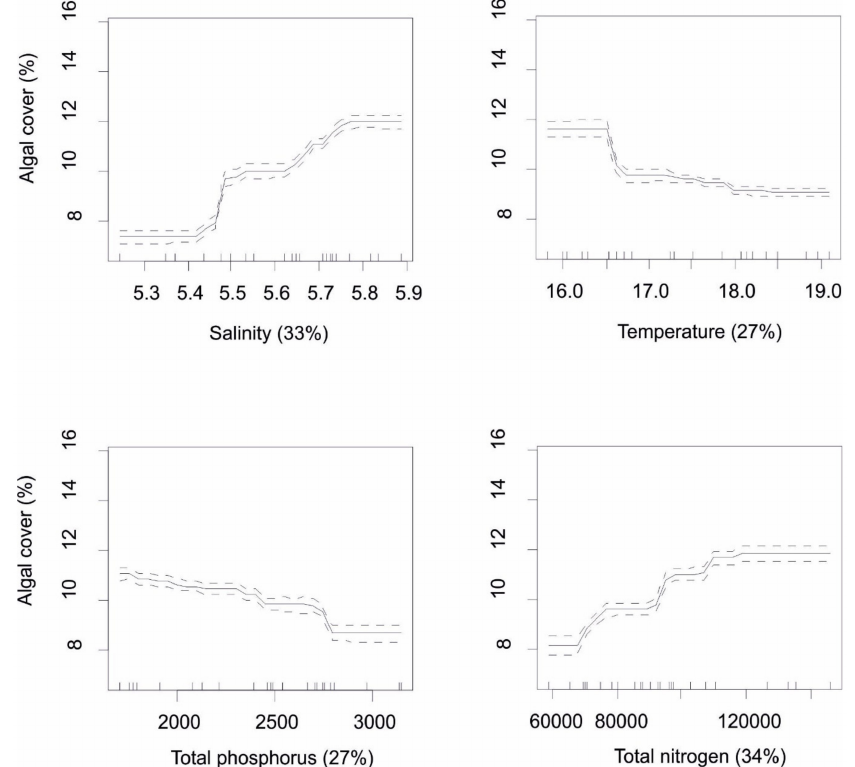
Figure 7. Partial dependence plots for boosted regression tree analyses relating the cover of macroalgae to the di ff erent environmental variables in Haapsalu Bay. The figure shows the e ff ect of an individual variable on the response when all other predictors are held at their mean values: positive fitted function values suggest that the cover of macroalgae responds positively, and negative values suggest the opposite. The relative importance of each variable is shown in parentheses on the x-axis. Solid lines depict shapes of the response between environmental variables and the cover of macroalgae (the fitted function without a smoother), and dashed lines represent standard error values of partial dependence curves. Each tick mark at the bottom of each graph represents the 10th percentile of the